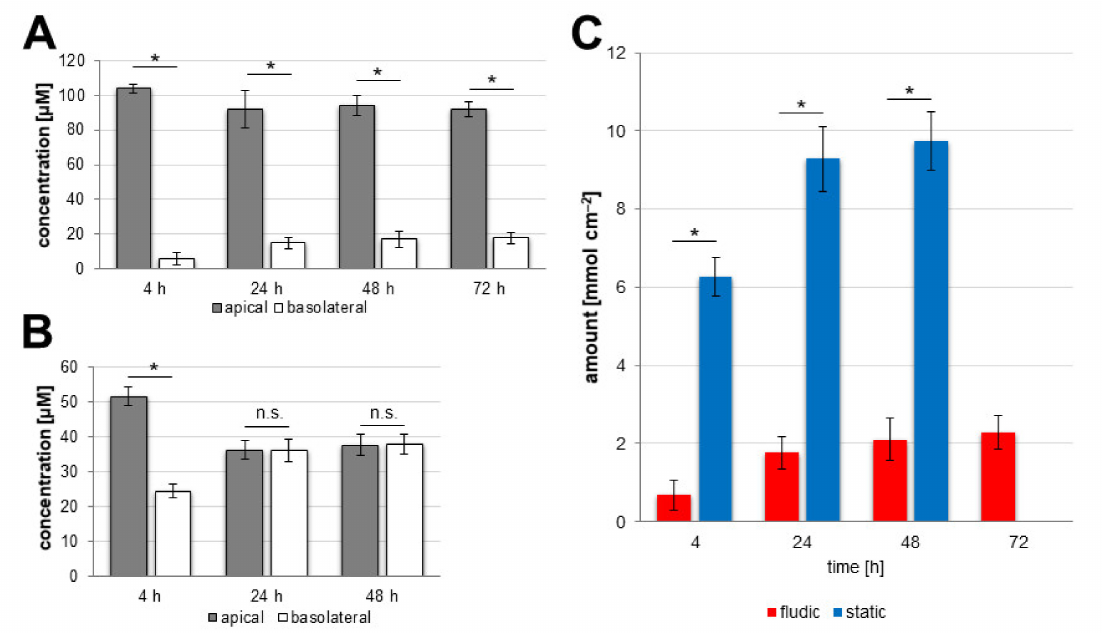
Figure 8. Transport of caffeine across the BBB in fluidic and static experimental settings. Determina- tion of permeated caffeine was performed at different time points. To the apical compartment of the models, 100 µ M caffeine was applied at day 10 of development and samples of both circuits were taken for measurement at the indicated time points. Distribution of caffeine between apical and baso- lateral compartment at different time points in the ( A ) fluidic and ( B ) static system. ( C ) Transported amount of caffeine dependent on BBB area for the fluidic (red) and static (blue) systems. Mean ± S.D. was calculated for three biological replicates; * p < 0.05, n.s. p >